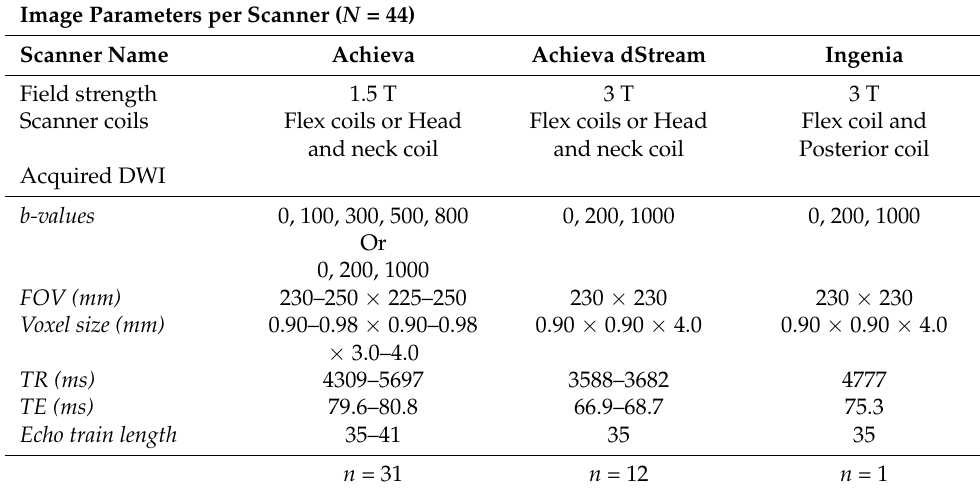
Table A1. Scanning parameters of the DWI-MRI acquisition for all scans ( n = 44).